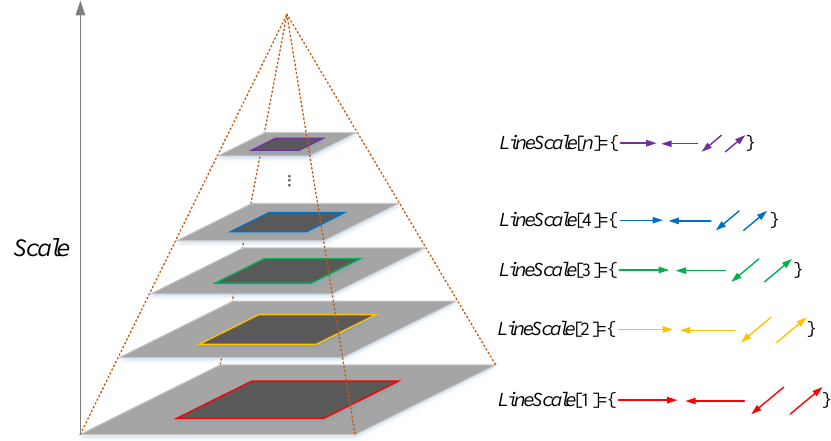
Figure 2. Illustration of line segment detection in an image pyramid. The first octave is the input image, and the other octave images are downsampled from it. Line segments detected from the i th octave image are represented as LineScale [ i